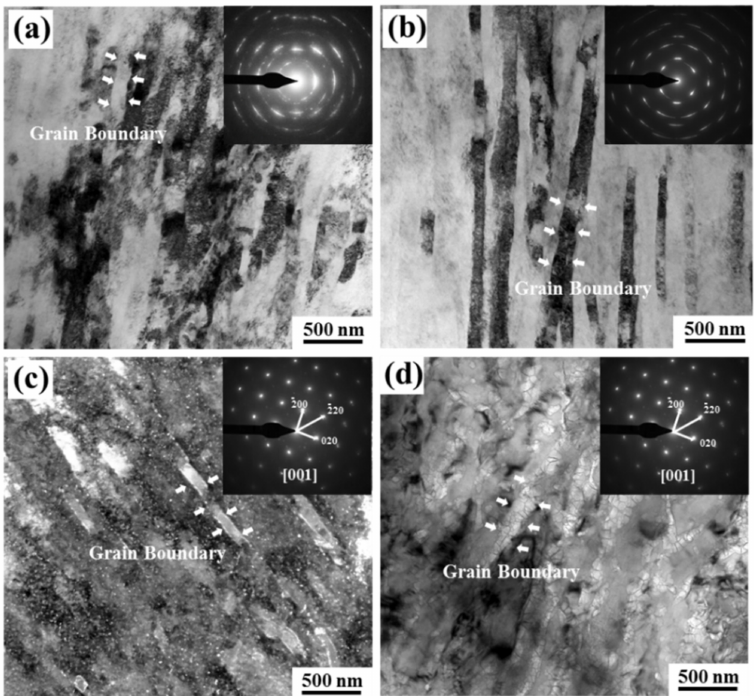
Figure 2. TEM microstructure and corresponding SAED patterns of Al-10.0Mg-1.0Zn-0.15Cu (wt%) alloy: ( a ) as-rolled, ( b ) 100 ◦ C-annealed, ( c ) 150 ◦ C-annealed, ( d ) 200 ◦